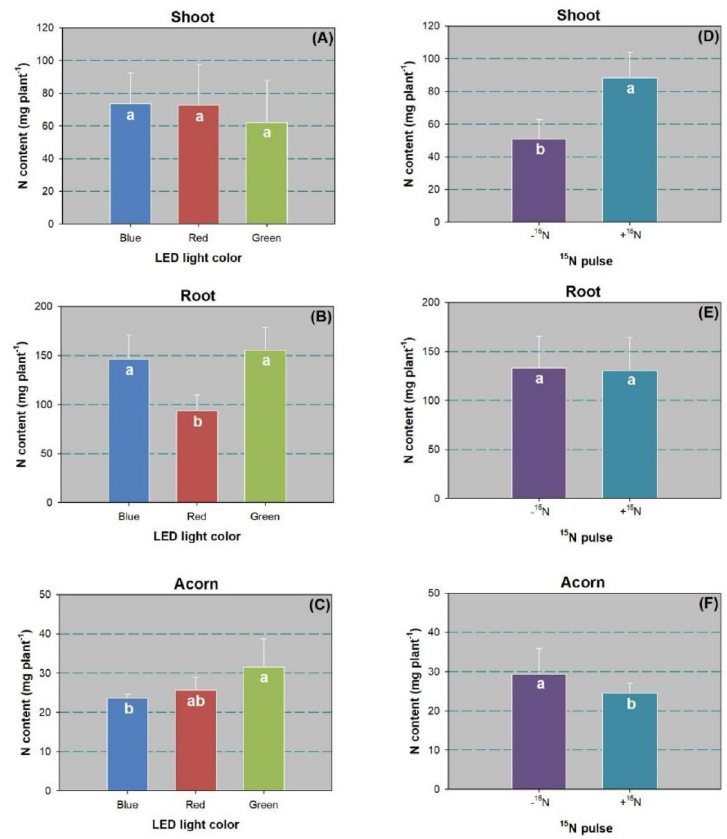
plant -1 (+ 15 N) or zero (- 15 N) ( n = 36). Columns and bars represent means and standard errors, respectively. Different letters denote a significant difference according to Tukey’s test at the 0.05